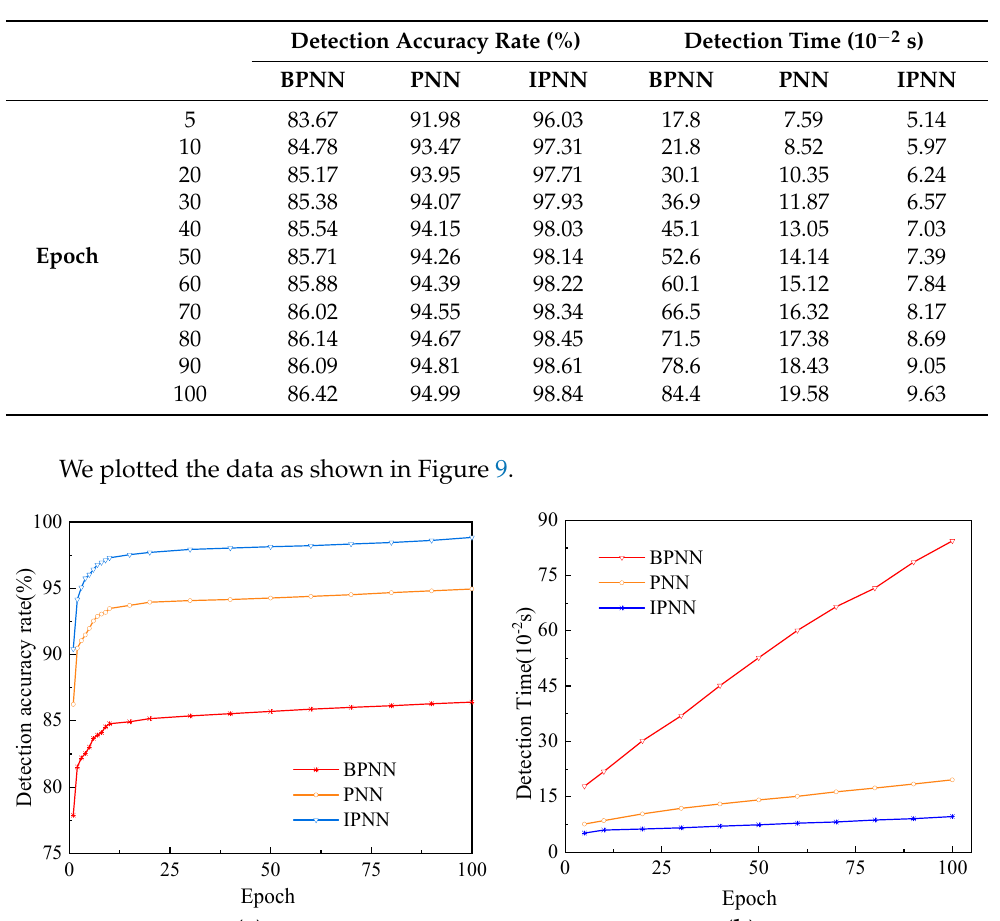
Table 4. Final detection results and time.